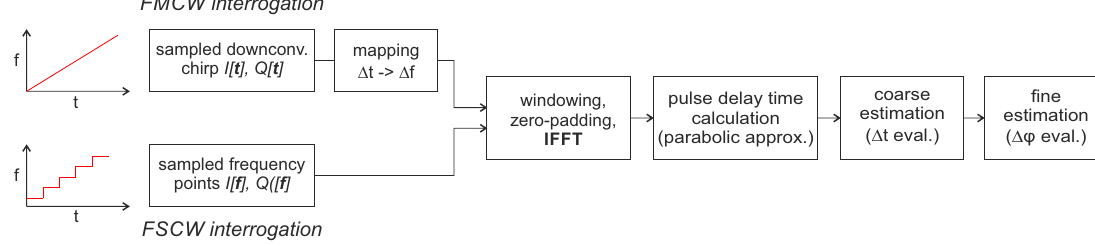
Figure 4. Signal processing flow chart for frequency domain sampling with reflective delay line SAW